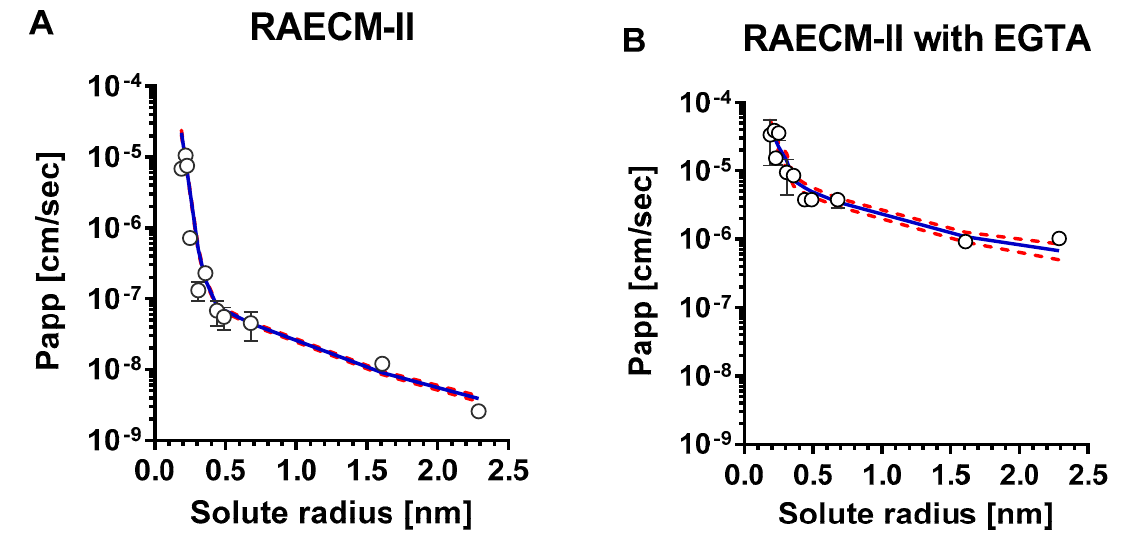
Figure A2. Mean values of P app versus corresponding solute radius across RAECM-II in the absence ( A ) and presence ( B ) of EGTA were analyzed using a maximum likelihood optimization approach, yielding small and large equivalent pore characteristics shown in Table A5. Circles represent mean P app and solid curve in blue denotes the heteropore characteristics that best fit the observed mean P app versus corresponding solute radius data. Standard deviation for each mean P app is also shown. Red dotted curves represent solid blue curve ± standard errors.